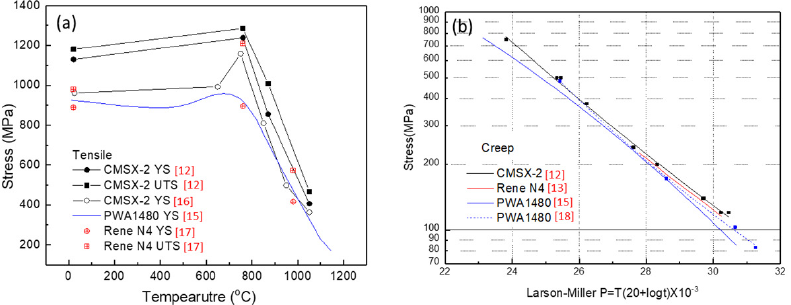
Figure 3. Mechanical properties of first-generation single crystal superalloys, ( a ) yield strength, ( b ) Larson-Miller plot [12–18].